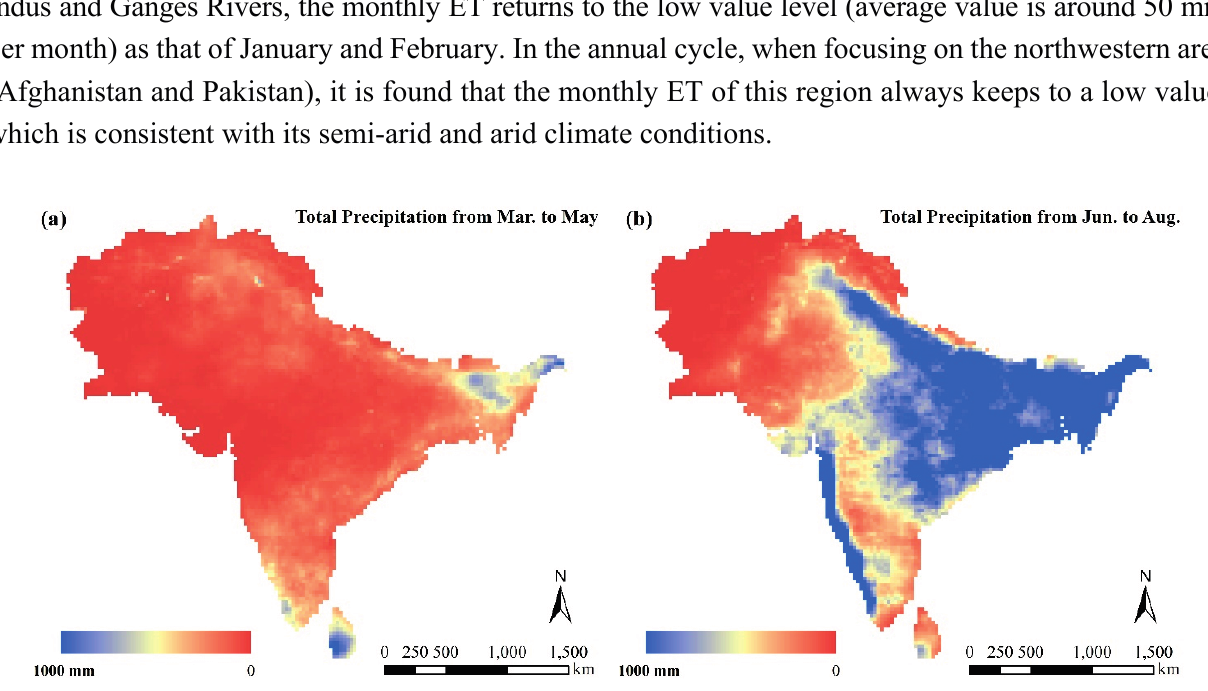
Figure 7. Total precipitation of ( a ) dry season (March to May) and ( b ) monsoon season (June to August) acquired from TRMM precipitation